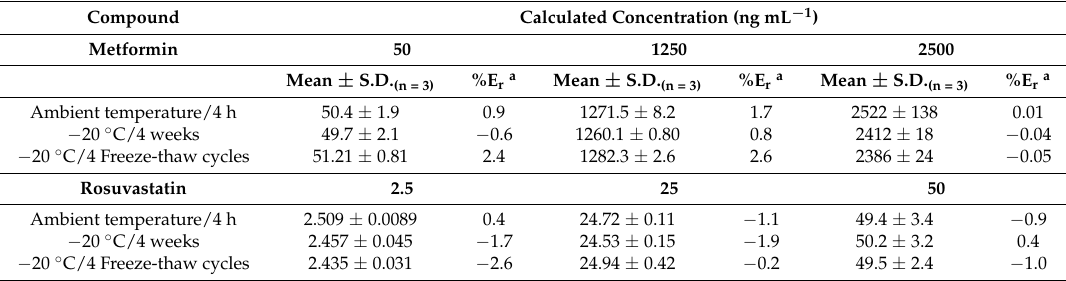
Table 4. Stability data for metformin and rosuvastatin in human plasma under various storage